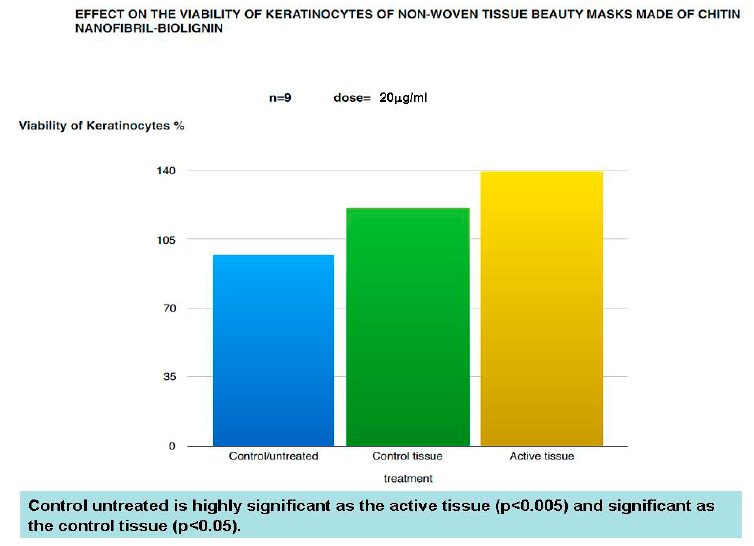
Figure 1. Viability of keratinocytes treated by the mask determined by the MTT method.